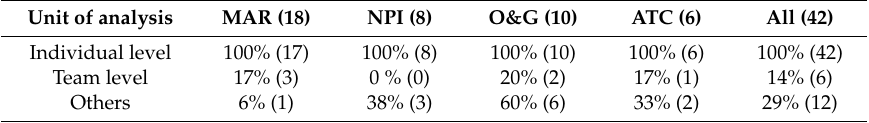
Table 3. Percentage (number) of papers that link CRM to effects at the individual and team